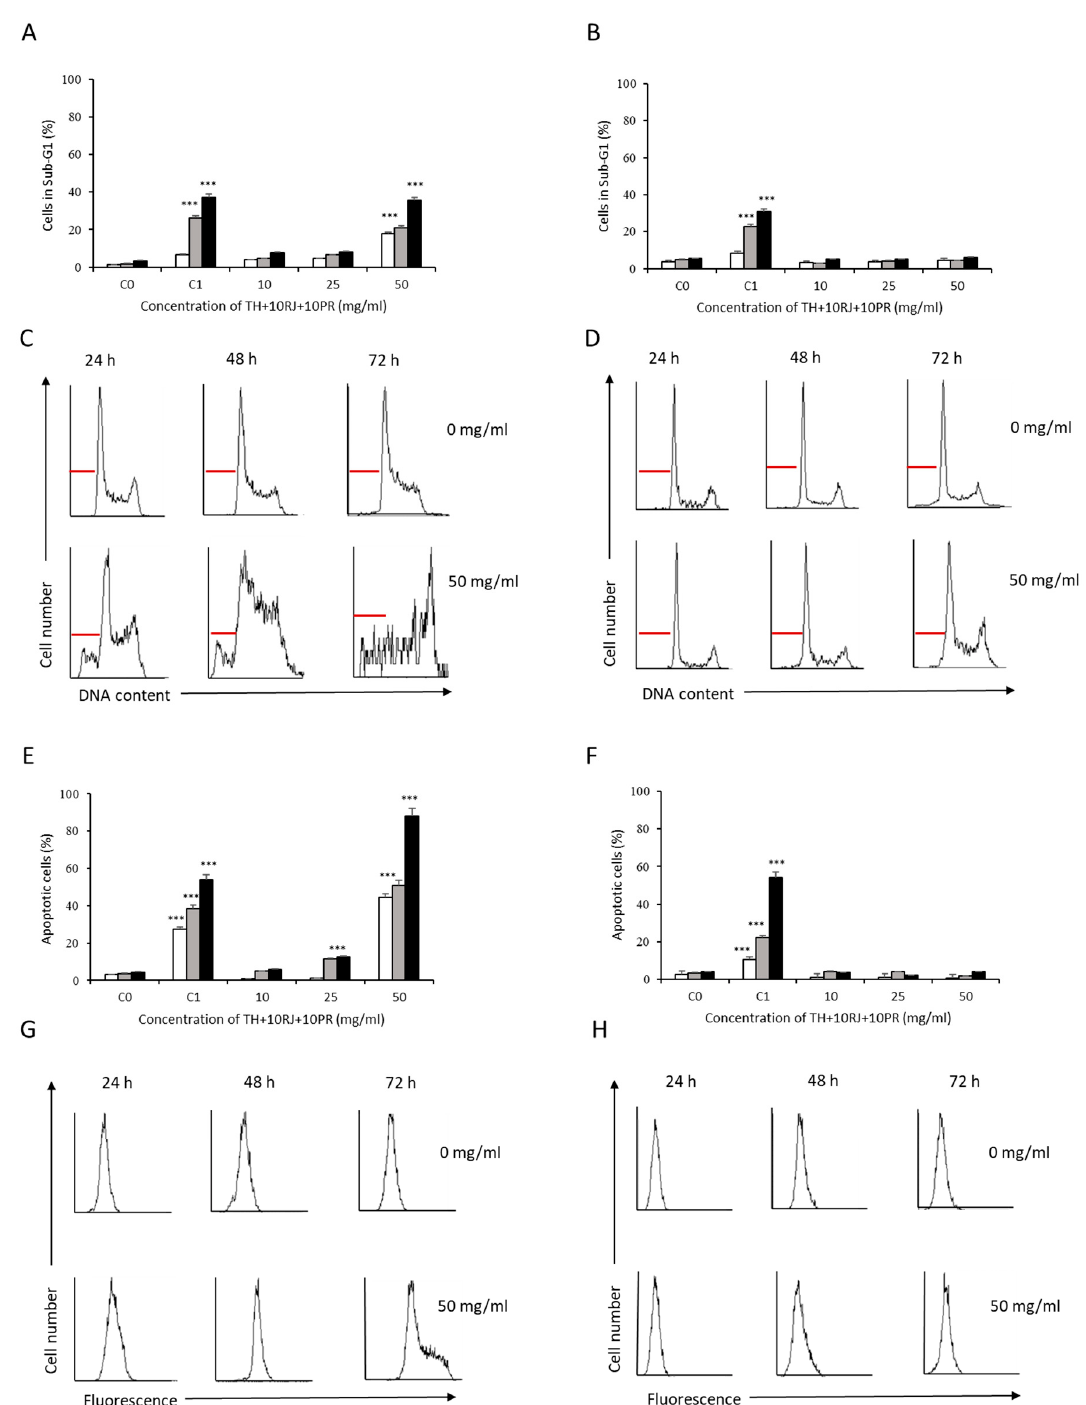
Figure 10. Effect of sample 12 (TH+10RJ+10PR) on human liver cell apoptosis. The cell cycle was determined using flow cytometry. HepG2 ( A ) and WRL-68 ( B ) cells were treated with different doses of sample 12 (10, 25, and 50 mg/mL) for 24 ( □ ), 48 ( ■ ), and 72 h ( ■ ). Representative histograms of the cell cycle of HepG2 ( C ) and WRL-68 ( D ) cells are shown; the red line indicates the sub-G1 phase. The percentage of apoptosis was analyzed by flow cytometry using the TUNEL assay. HepG2 ( E ) and WRL-68 ( F ) cells were cultured with different doses of sample 12 (10, 25, and 50 mg/mL) for 24 ( □ ), 48 ( ■ ), and 72 h ( ■ ). Representative histograms of the fluorescence intensity in HepG2 ( G ) and WRL-68 ( H ) cells are presented. C 0 , untreated cells; C 1 , cells treated with etoposide (50 µM). Asterisks indicate a significant difference from the control (C 0 ). *** p ≤ 0.001.